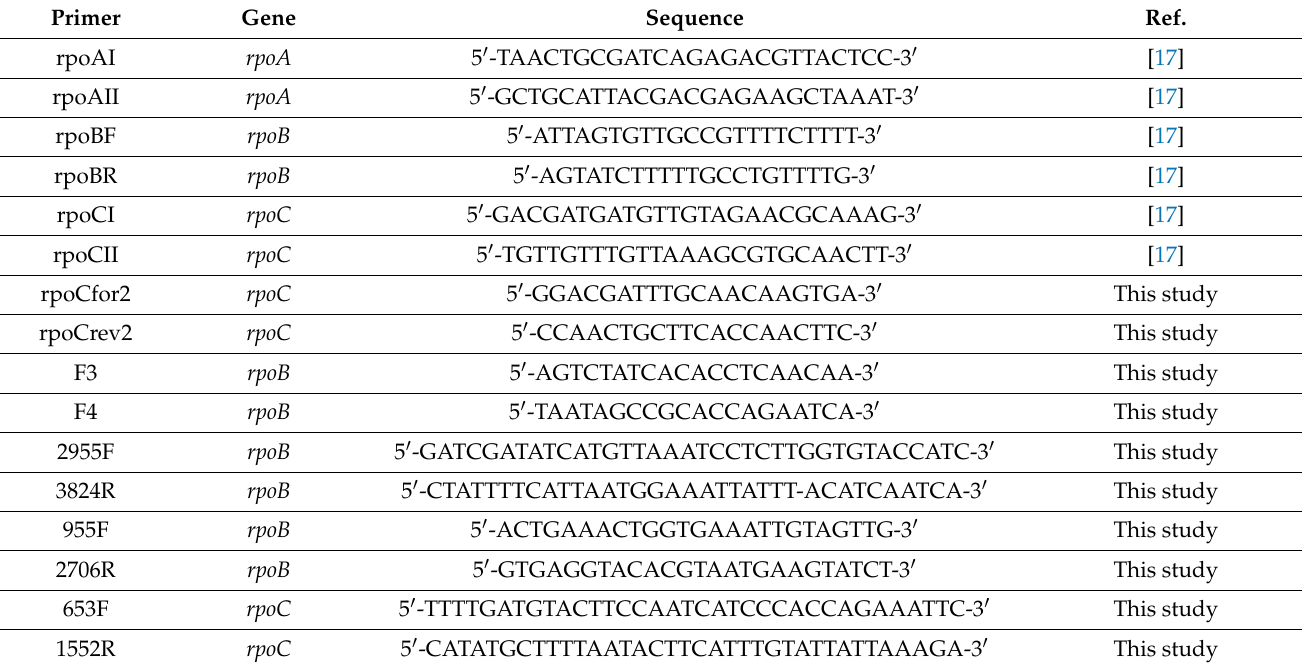
Table 3. Primers used for the PCR amplification and sequencing of